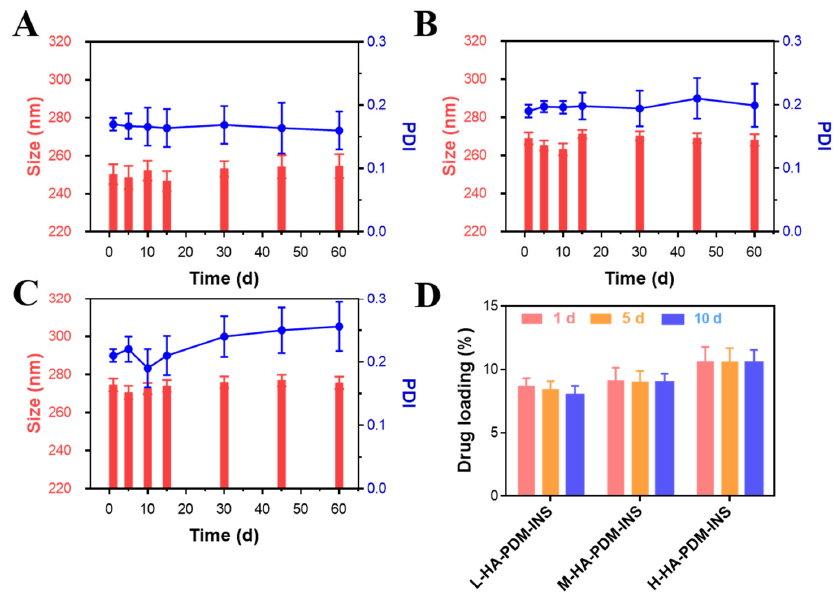
Figure 3. The size stability of L-HA–PDM–INS ( A ), M-HA–PDM–INS ( B ), and H-HA–PDM–INS ( C ) stored at 4 °C for 60 d. ( D ) Drug loading of three nanoparticles during storage (X ± SD, n = 3).